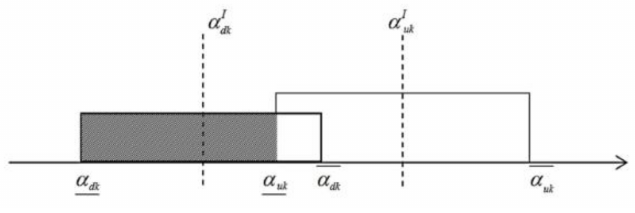
Figure 2. Scheme for PoDE.